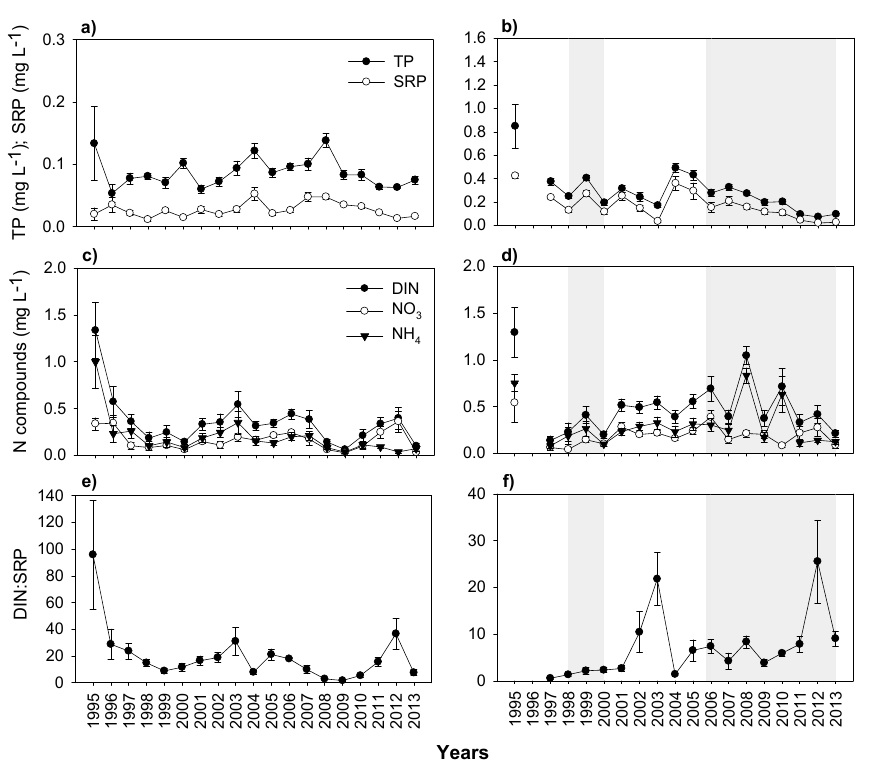
Figure 6. Changes in yearly mean (with ± SE) nutrient concentrations from 1995 to 2013 in Lake Mogan (left panels) and Lake Eymir (right panels); ( a , b ) total phosphorus and soluble reactive phosphate (TP ‐ SRP); ( c , d ) Nitrogen compounds; ( e , f ) dissolved inorganic nitrogen: soluble reactive phosphate (DIN:SRP) (shaded periods indicate the first and second biomanipulation periods). Note the scale differences on the y ‐ axes.